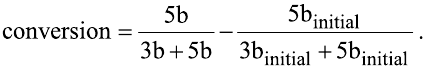
(Figure NMR 2 and Table NMR 2 in Supporting Information File 2).